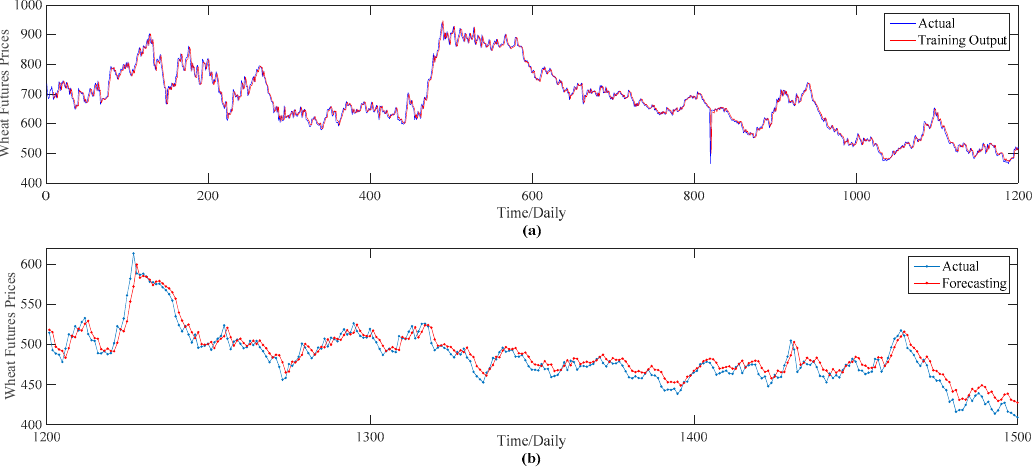
Figure 6. Training and forecasting results of the PSO–BPNN model (Wheat).